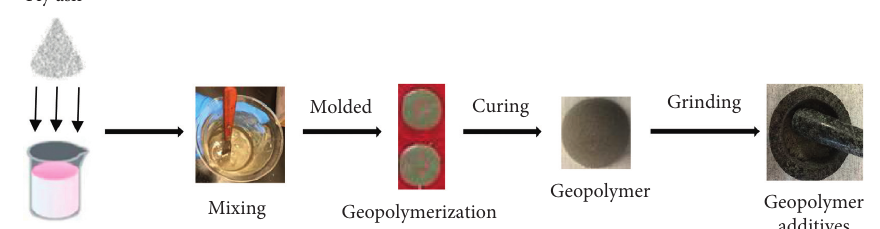
Figure 1: Preparation of geopolymer additives.